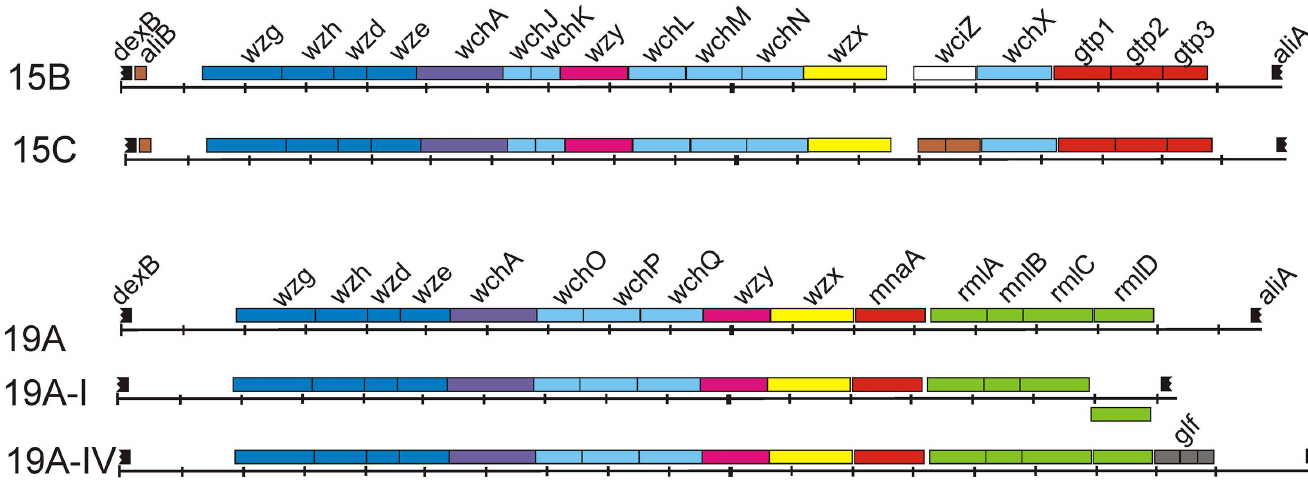
Fig 2. The cps clusters of serotypes15B and 15C and the variations in the cps clusters of serotype 19A detected in this study. The genesare coloured using the scheme reportedby Bentley et al. [21]: regulatorygenesin dark blue, initial transferase in violet, glycosyl transferase in light blue, polymerase in pink, flippase in yellow, acetyl transferase in white, dTDP-L-rhamnose pathwaygenes in green, UDP-N-acetyl-D-mannosaminepathway genesin red, glf genes in grey, pseudogenesin brown, and flankinggenes in black. The flanking transposons are not indicated.